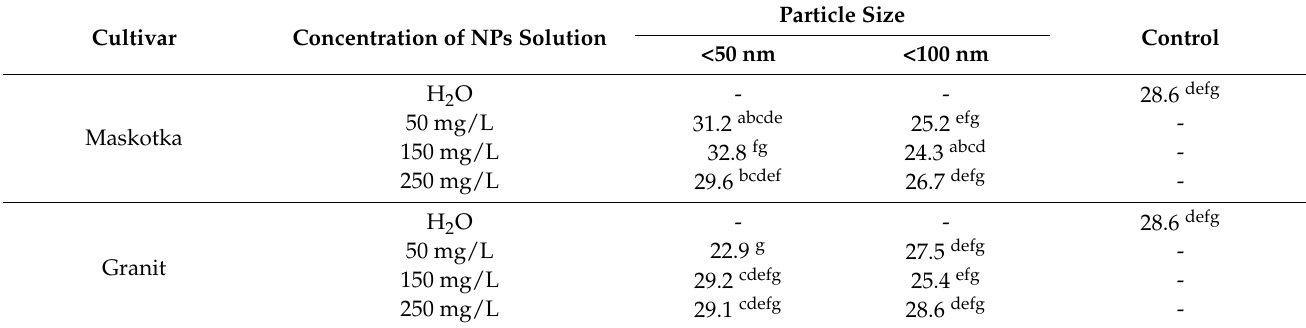
Table A4. The results of coefficient of velocity of germination (CVG) parameter obtained after treatment and statistic calculations. For this growth parameter, three variables were taken under consideration (NPs suspension, cultivar type, and the size of used NPs). In statistical part of the table, the statistical significance is expressed as “-”, which means that p -value was higher than 0.05 and certain parameters had no significant influence on the results; “*” means that p -value is lower than 0.05, and “***” means that p -value is lower than 0.001. Small letters indicate the significant differences for p -value ≤